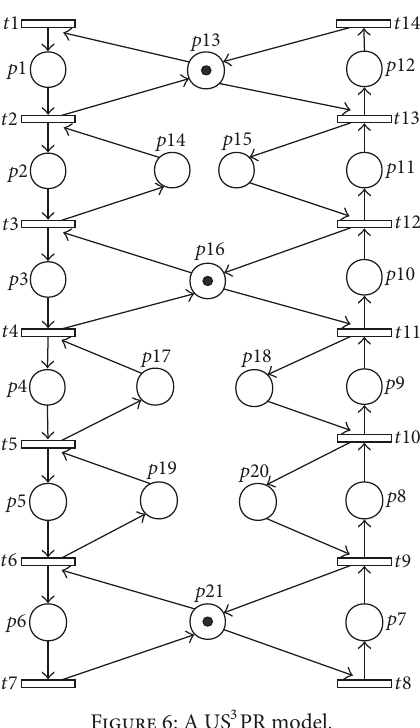
Figure 6: A US 3 PR